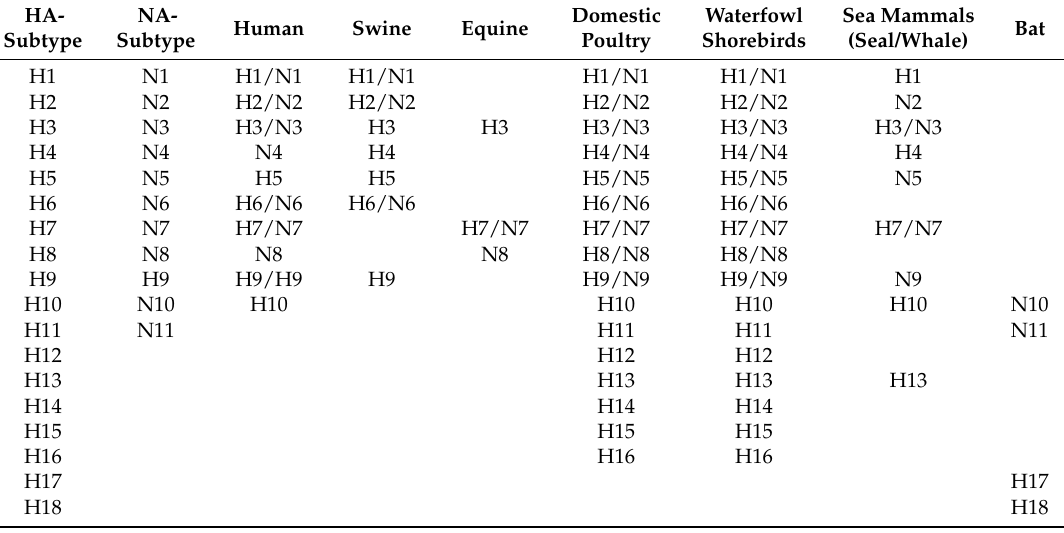
Table 2. Host range of different hemagglutinin (H1–H18) and neuraminidase (N1–N9)